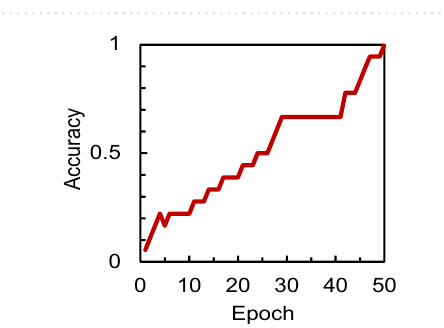
Figure 6. Evaluation results as the associative memory.